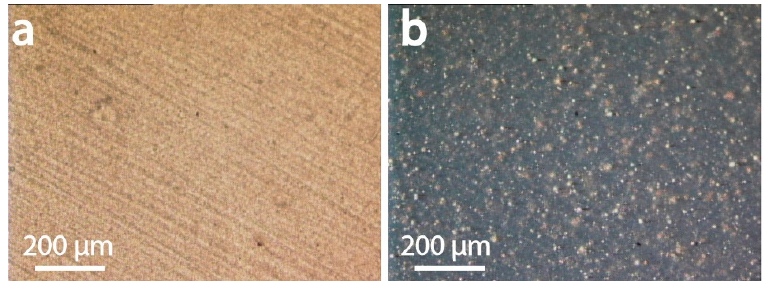
Figure 10. Transmission microscopy images obtained for ( a ) uDiam-PLA composites and ( b ) uDiam- PLA composites images with the samples between cross polarizers highlighting crystalline phase in uDiam-PLA (bright areas).